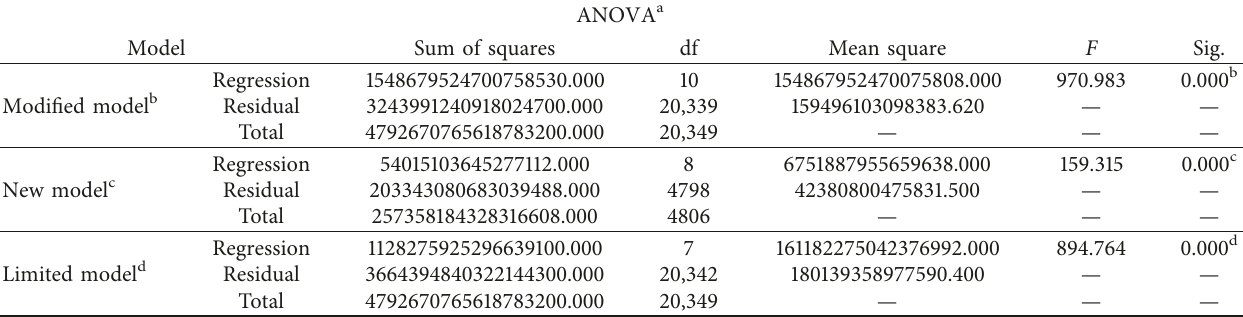
Table 15: ANOVA for a DOE medium office building depending on different models.